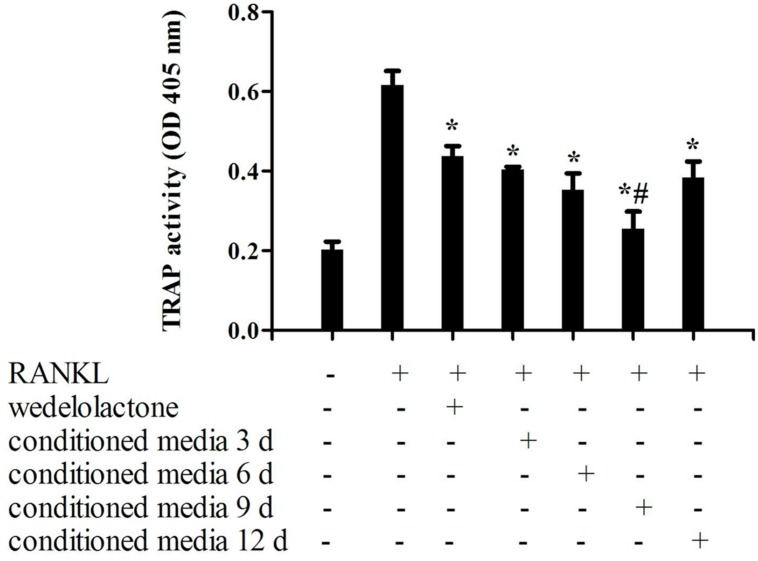
Effect of wedelolactone-treated bone marrow mesenchymal stem cell (BMSC) conditioned media on osteoclastic differentiation of RAW264.7 cells. Different fractions of wedelolactone-treated BMSC conditioned media were added to RAW264.7 cells. After 4 days of incubation, cultures were fixed, and TRAP activity was assayed. Data are expressed as mean ± SEM of three independent experiments. ∗P < 0.05 compared with RANKL-treated cells. #P < 0.05 compared with wedelolactone-treated cells.